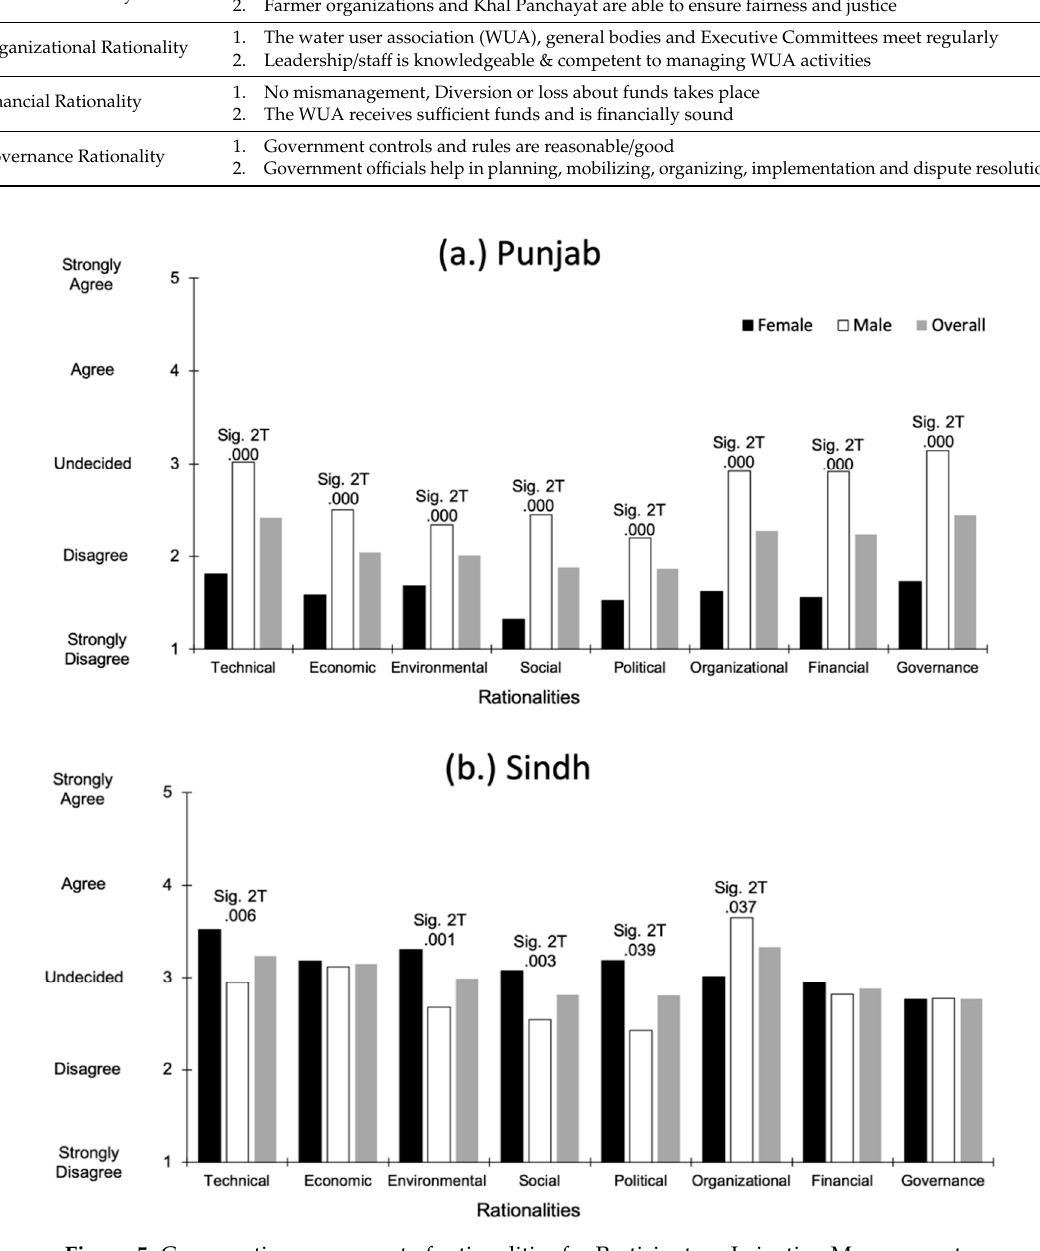
Figure 5. Comparative assessment of rationalities for Participatory Irrigation Management.